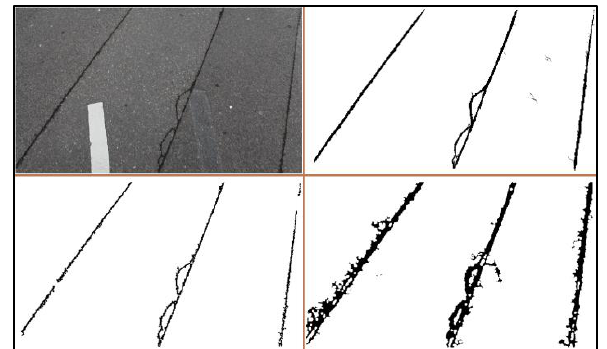
Figure 7. Comparison of crack detection using three different methods; original image (top left), final result of crack detection using LF (top right), HPF (lower left) and LBP (lower right)